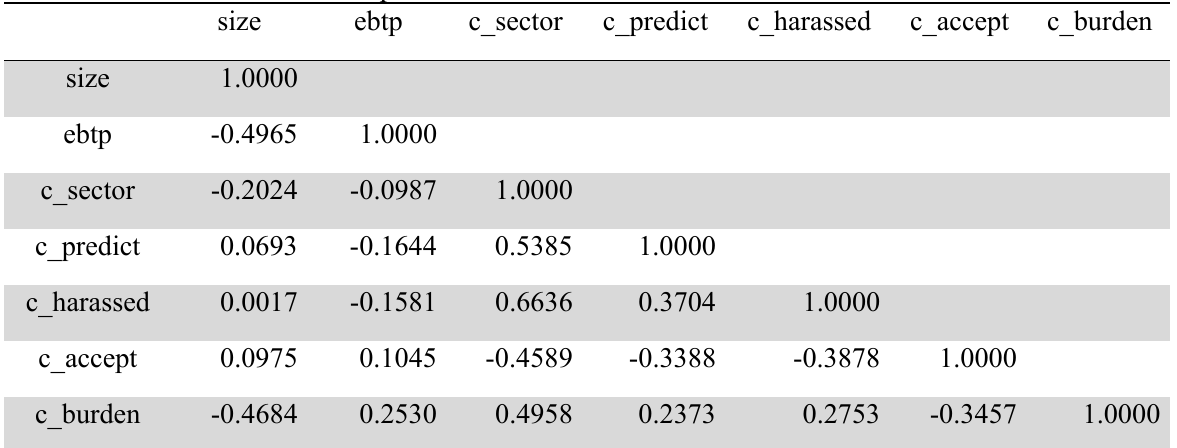
Correlation coefficients between pairs of